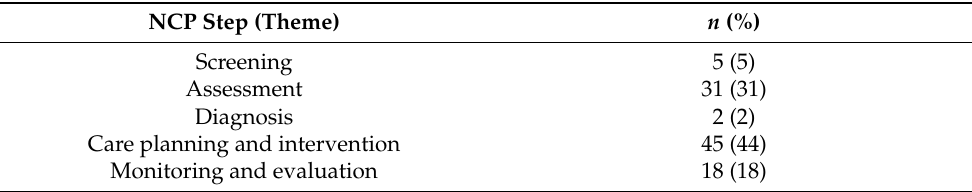
Table 2. Identified activities for de-implementation mapped to the nutrition care process steps.